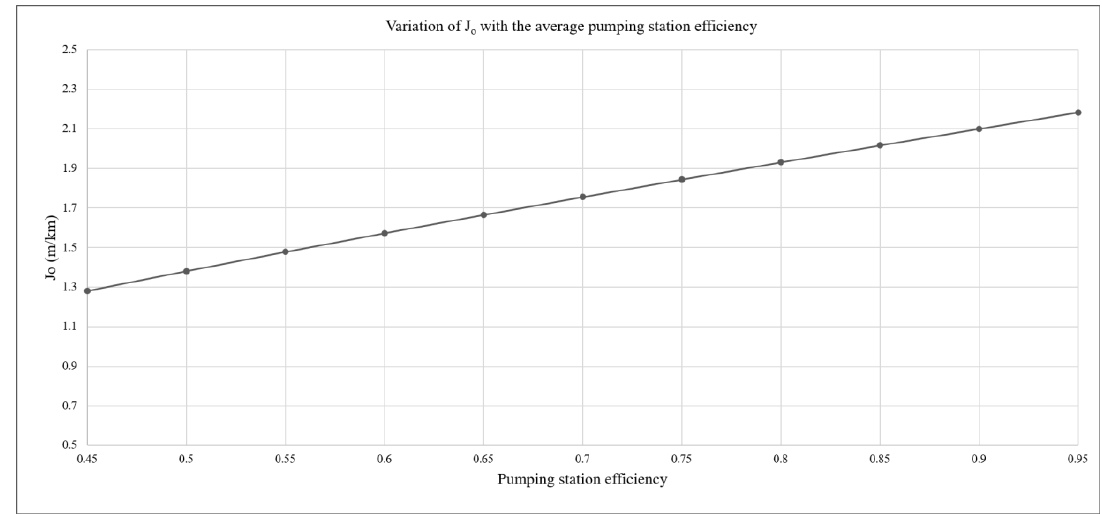
Figure 11. Variation in J 0 with average pumping station efficiency (case 1, steady network).